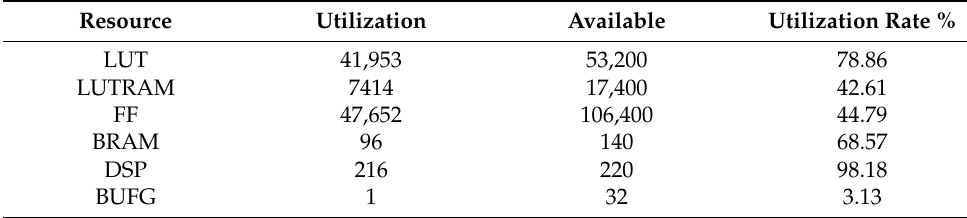
Table 2. Utilization of FPGA